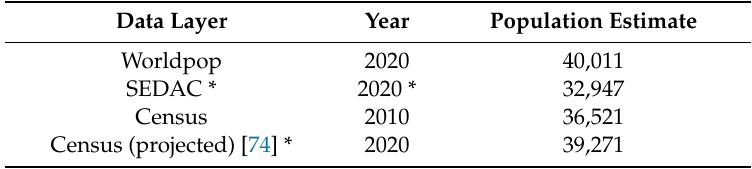
Table 3. Comparison of three available population datasets that allow estimating how many people live within the two selected